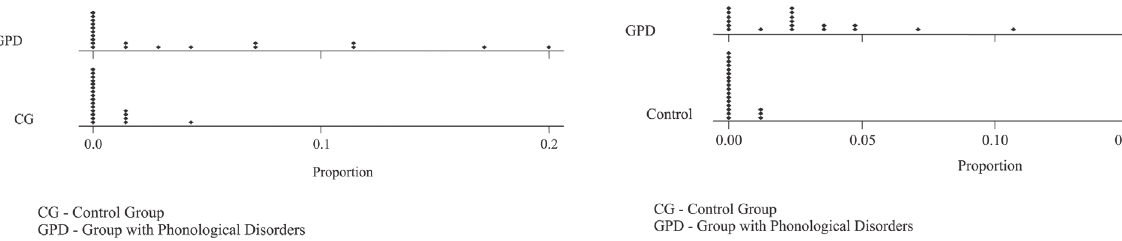
Figure 2 - Points of proportion of distortion occurrences in the imitation